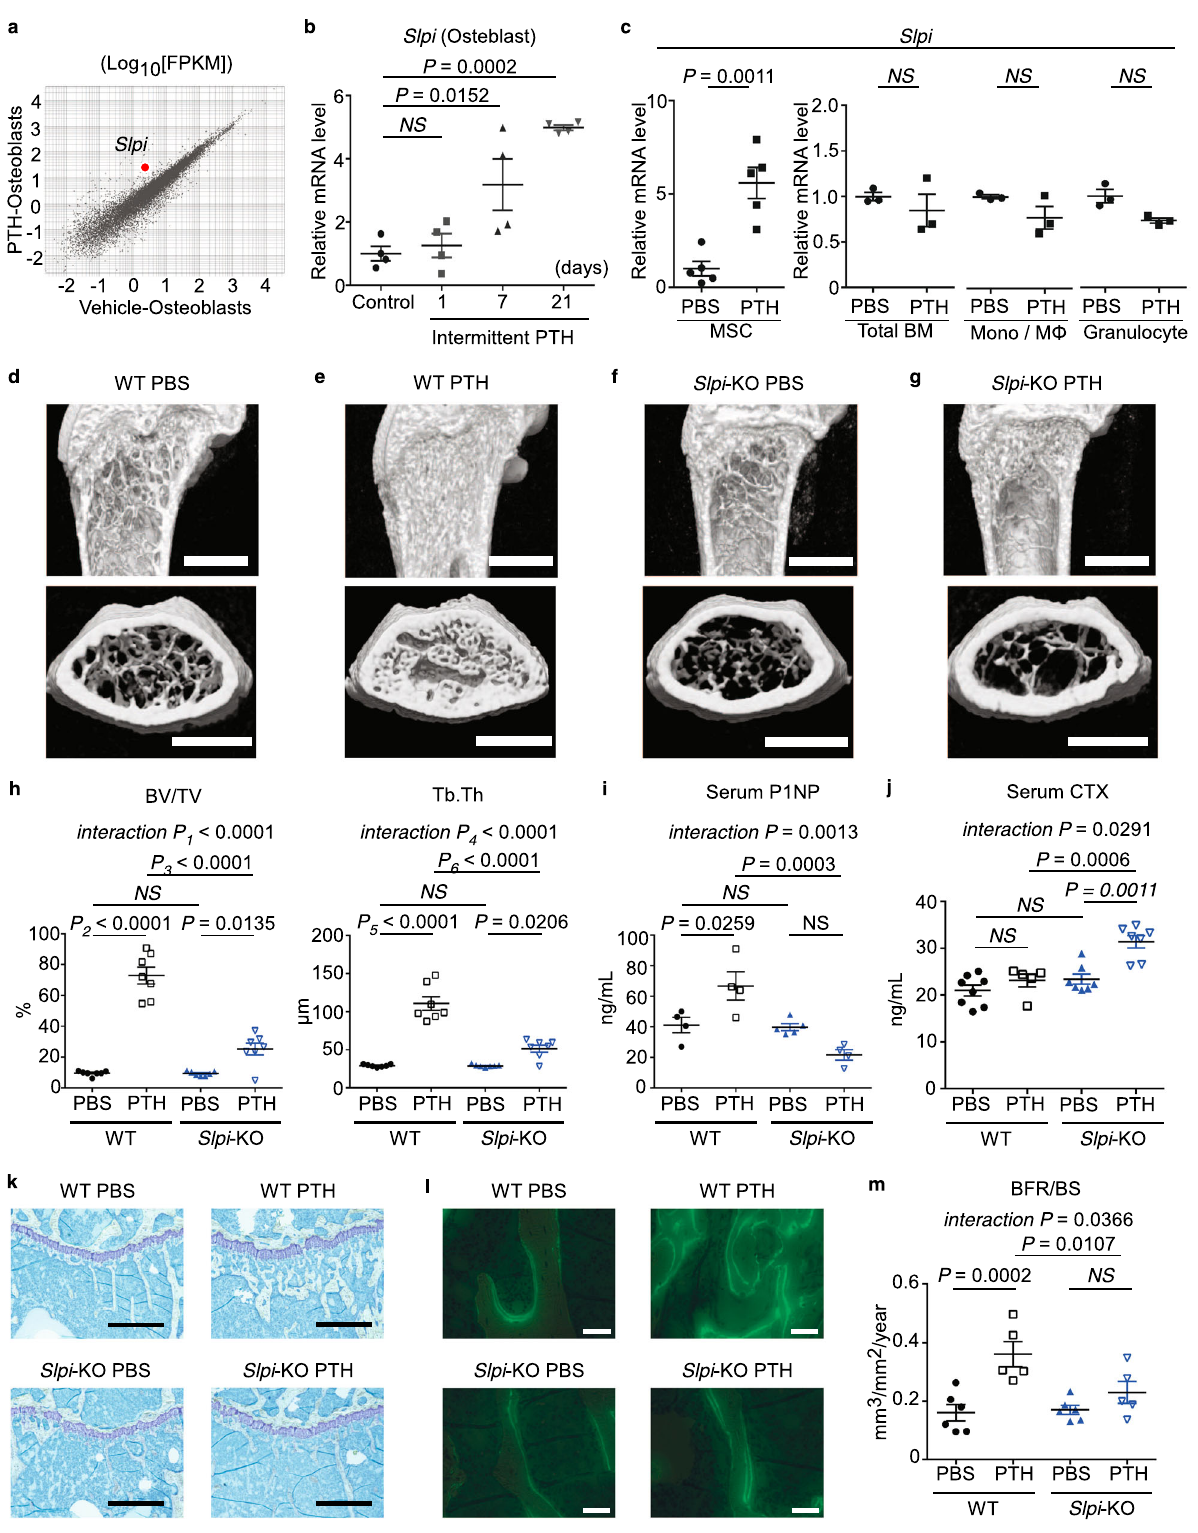
vehicle-treated WT control mice, which was disrupted in Slpi -KO mice (Fig. 1i). Assessment of the serum levels of C-terminal telopeptide of collagen (CTX), a biochemical marker